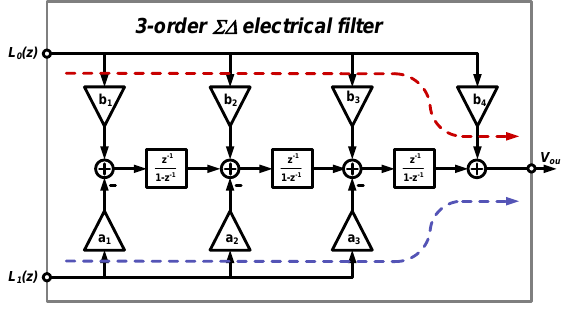
Figure 2. The architecture of the third-order electrical Σ∆ loop filter.